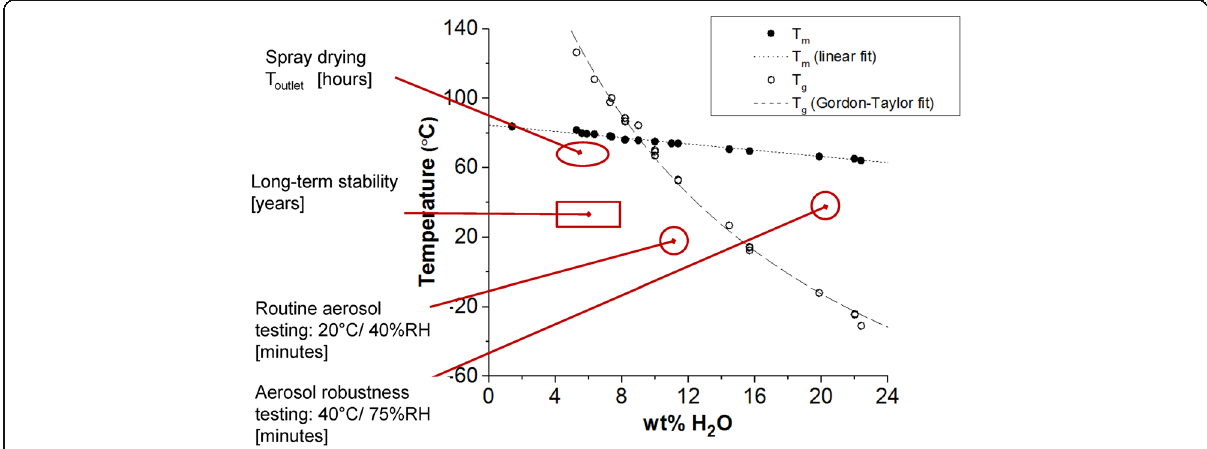
Fig. 5 Tobramycin Inhalation Powder (TIP) state diagram: Impact of water on the solid state (Adapted from Miller et al.